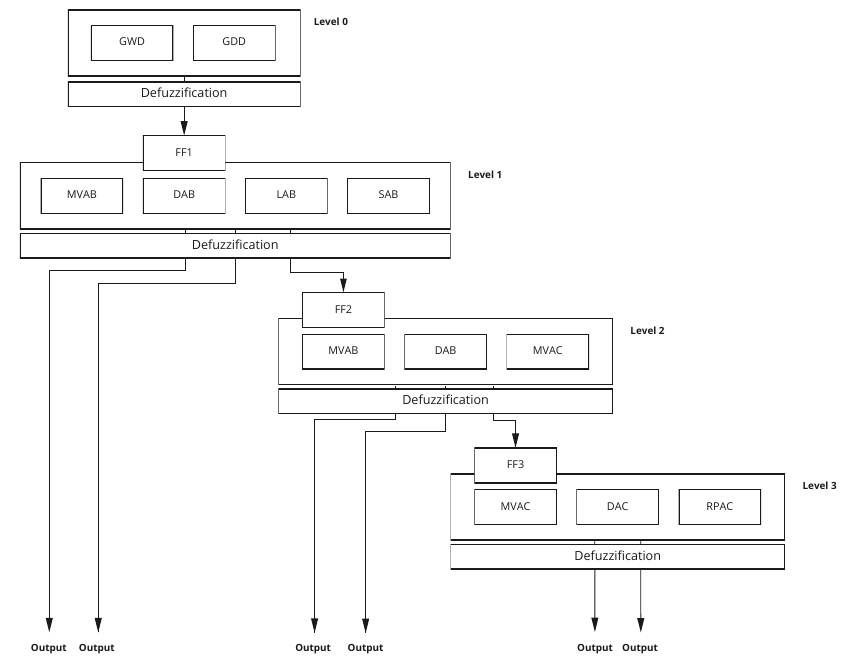
Figure 3. Hierarchical rules architecture: Rules are grouped into modules according to their roles in the system. Each module has the ability to compute a defuzzification process delivering a final output or connecting to the next level. In the latter case, the input becomes part of the antecedent of a new set of rules, in this way up to the last level if